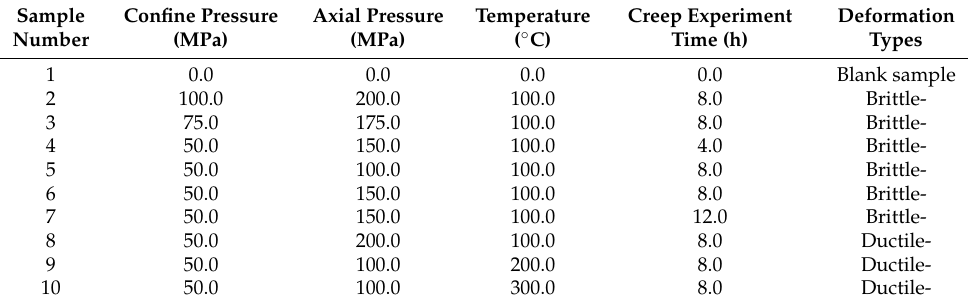
Figure 2. A schematic diagram of the deformation experimental system (modified from Liu et al. [14]). Table 2. Experimental conditions for the coal samples. Table 2. Experimental conditions for the coal samples.